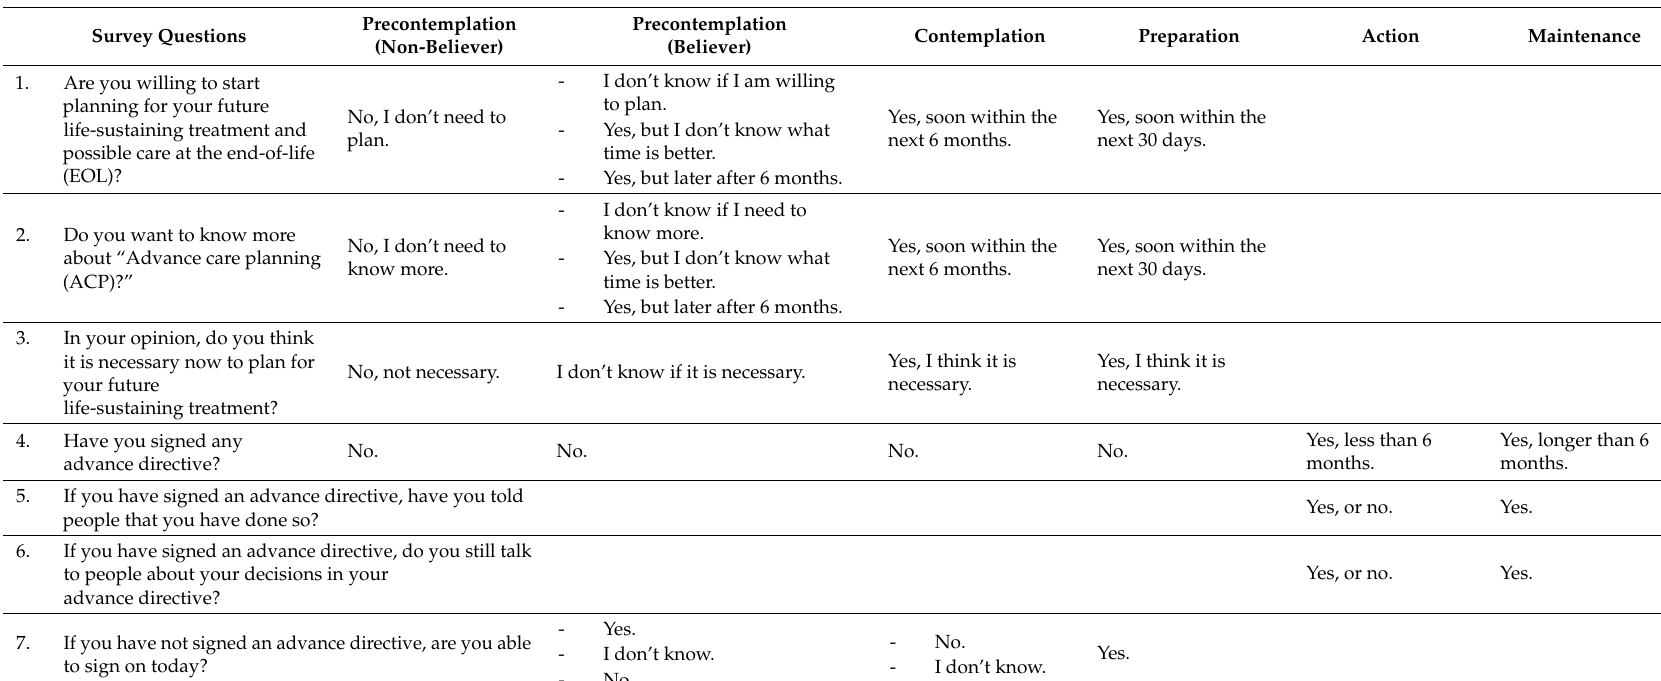
Table 1. The stage of change for the Advance Care Planning